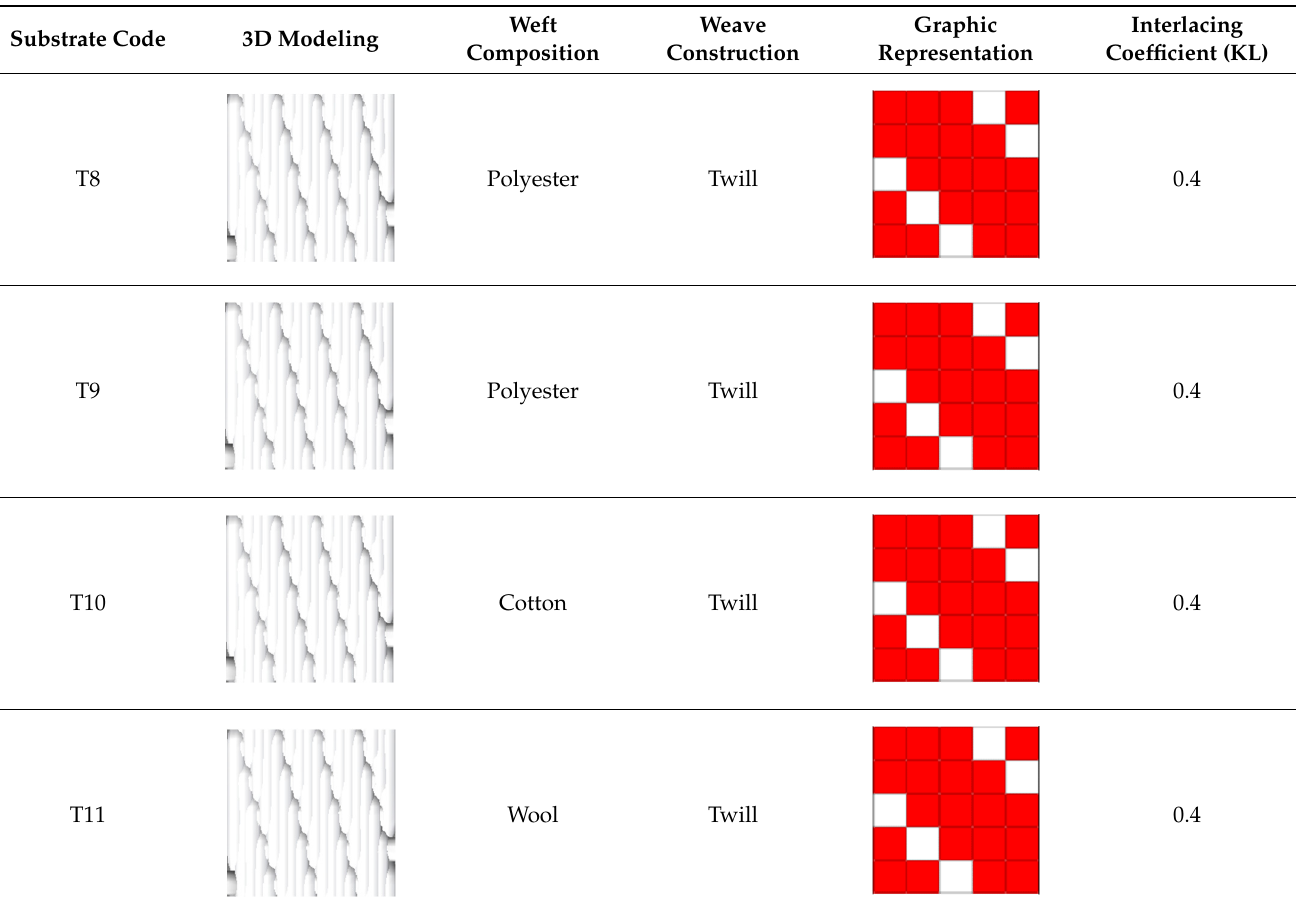
Table 1. Textile substrate’s characterization (I): composition and ligament. Table 2 completes the main characteristics of the fabrics, adding the characteristics of